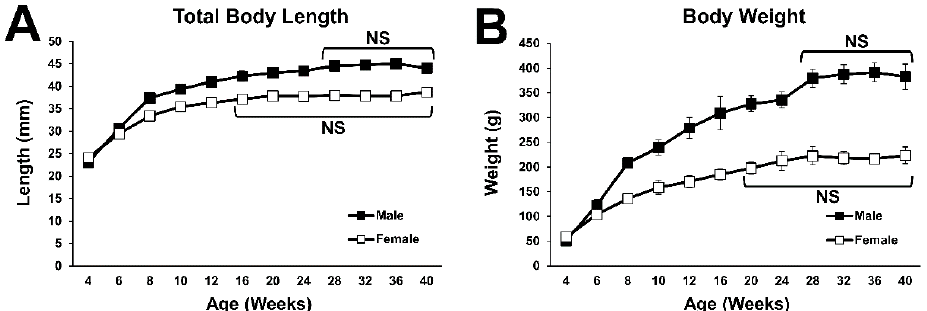
Figure 1. Growth curves of body size. ( A ) Growth curve for the total length from muzzle to tail. No statistical difference was detected between the time points at 28 weeks of age and older in males, and between the time points at 16 weeks of age and older in females. ( B ) Growth curve of body weight. No statistical difference was detected between the time points at 28 weeks of age and older in males, and between the time points at 20 weeks of age and older in females.